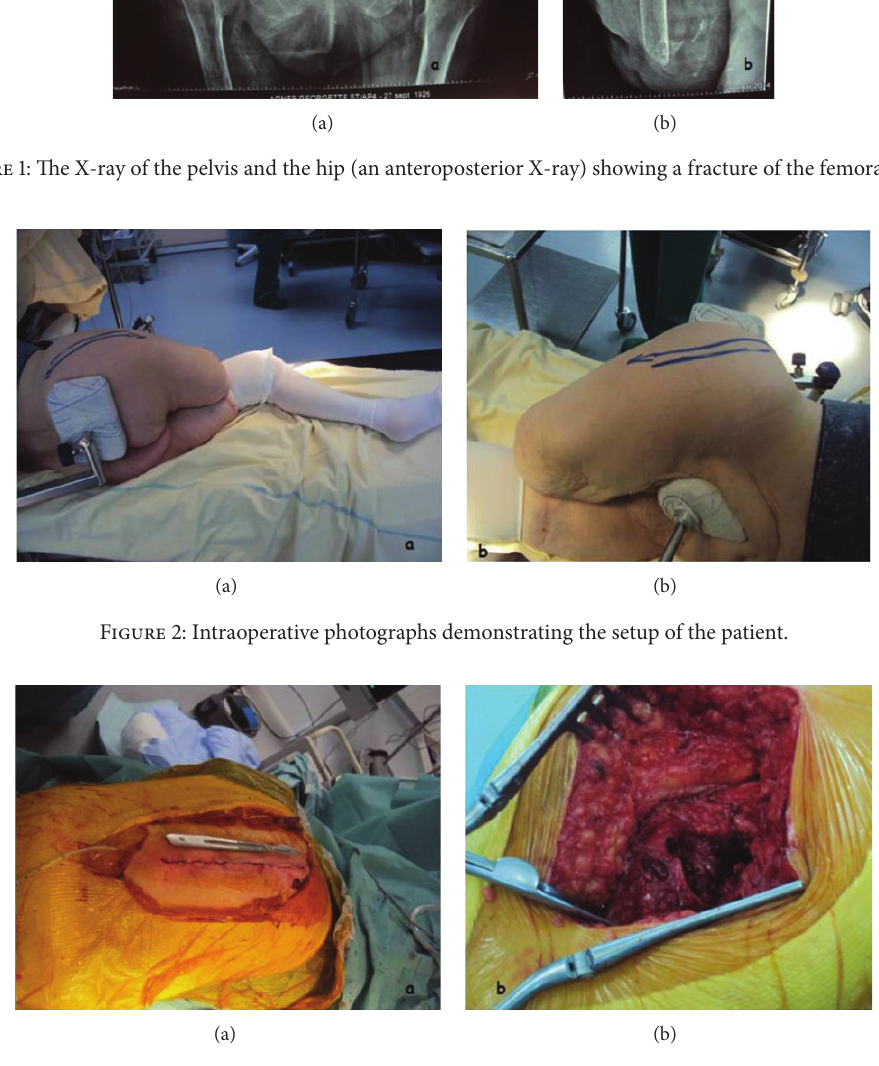
Figure 3: A clinical picture has showed the Hardinge approach. (a) The skin incision. (b) Articular